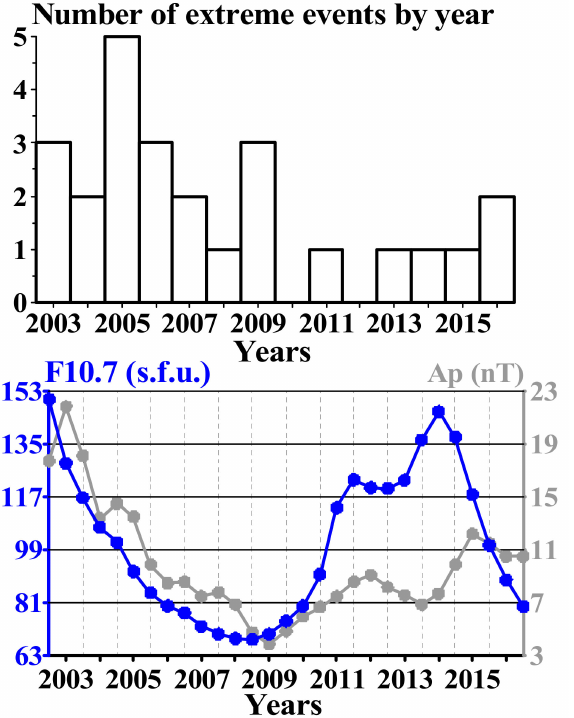
Figure 4. Year-by-year distribution of extreme ionospheric events from the Irkutsk database (upper panel) and year-by-year variations in solar (F10.7, blue) and geomagnetic (Ap, grey) activity indices (lower panel). Both indices are presented by one-year running mean values with half-year